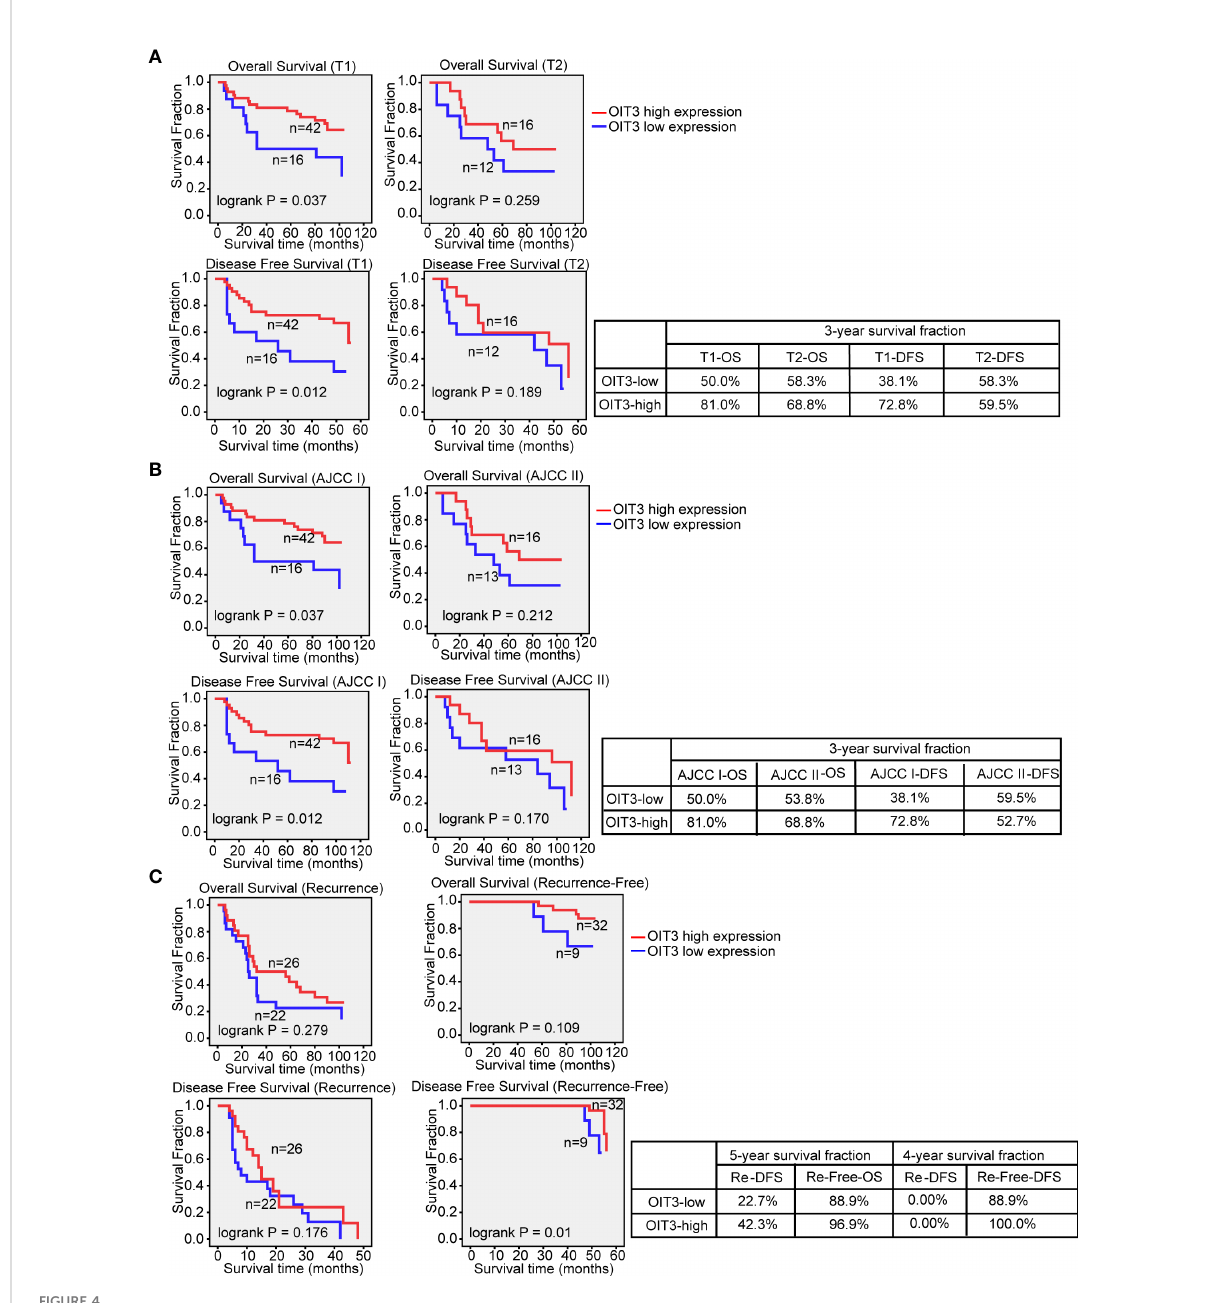
FIGURE 4 OIT3 was positively associated with HCC outcome at T1 and AJCC I stage. (A) The effect of OIT3 expression on the clinical outcomes of HCC patients at T1 and T2 stage. As shown, HCC patients at the T1 stage with a higher level of OIT3 had a better prognosis (3-year OS rates: OIT3 high group vs. OIT3 low group, 81.0% vs. 50.0%; 3-year DFS rates: OIT3 high group vs. OIT3 low group, 72.8% vs. 38.1%). (B) The effects of OIT3 expression on the clinical outcomes of HCC patients at AJCC I and AJCC II stage. As shown, HCC patients at AJCC I stage with a higher level of OIT3 had a better prognosis (3-year OS rates: OIT3 high group vs. OIT3 low group, 81.0% vs. 50.0%; 3-year DFS rates: OIT3 high group vs. OIT3 low group, 72.8% vs. 38.1%). (C) As shown, HCC patients with free recurrence and a higher level of OIT3 had a better prognosis (4-year DFS rates: OIT3 high group vs. OIT3 low group, 100.0% vs. 88.9%). OS, overall survival; DFS, disease-free survival; Re,